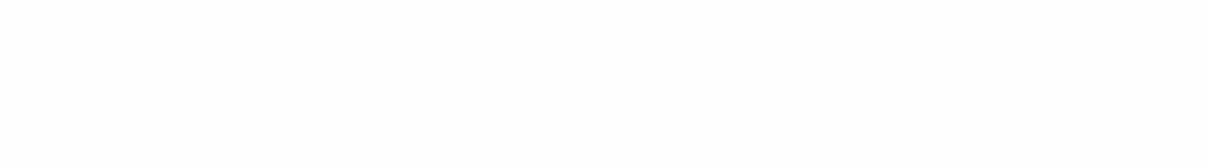
TABLE 2. Frequency of symptoms in patients with